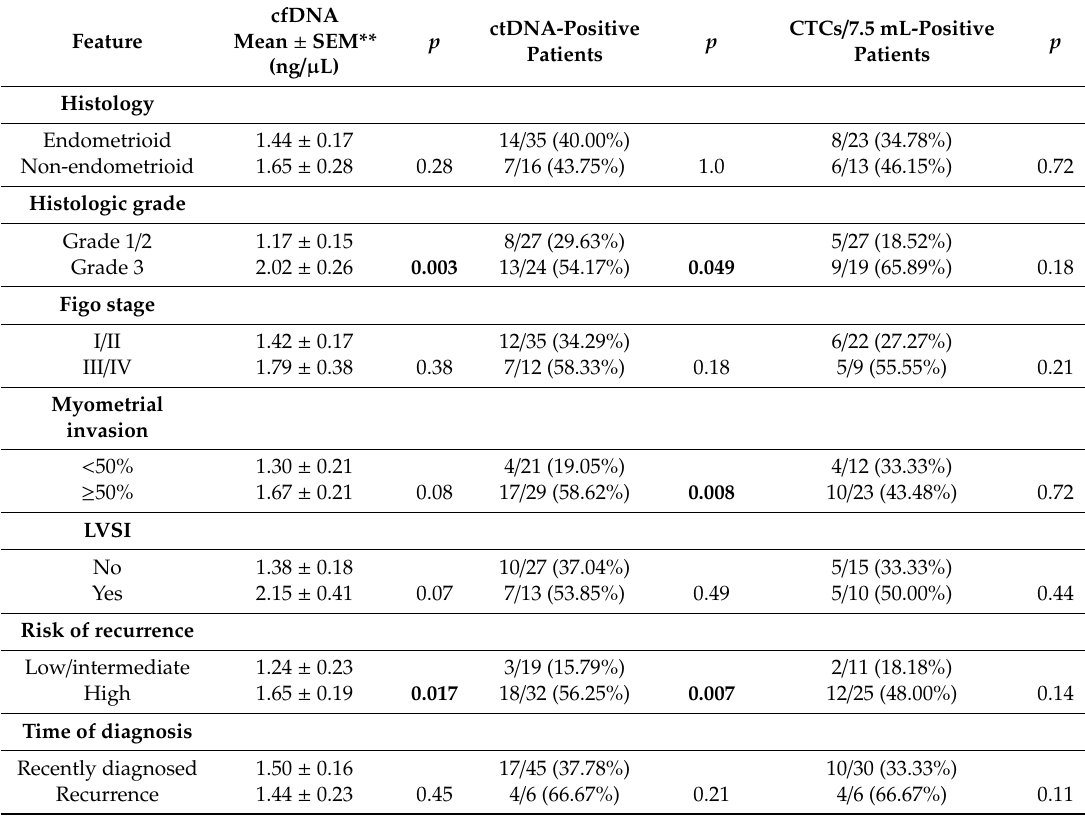
Table 2. Levels of cfDNA, circulating tumor DNA (ctDNA), and circulating tumor cells (CTCs) according to the clinicopathologic features of patients with